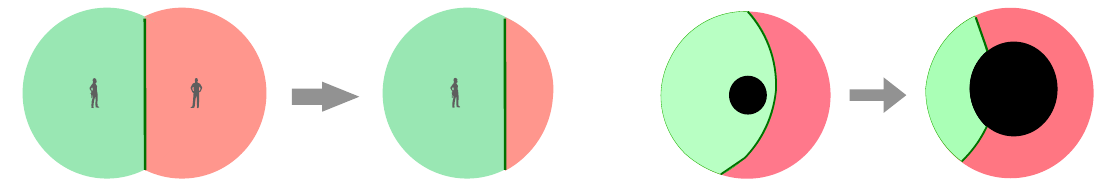
Figure 1 . A domain wall sweeping the center of the ‘false AdS vacuum’ where an inertial observer could rest (left), or entering the horizon of a black hole